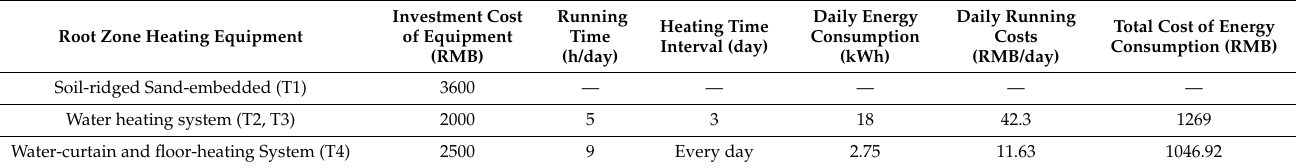
Table 5. Economic comparison of different root zone heating